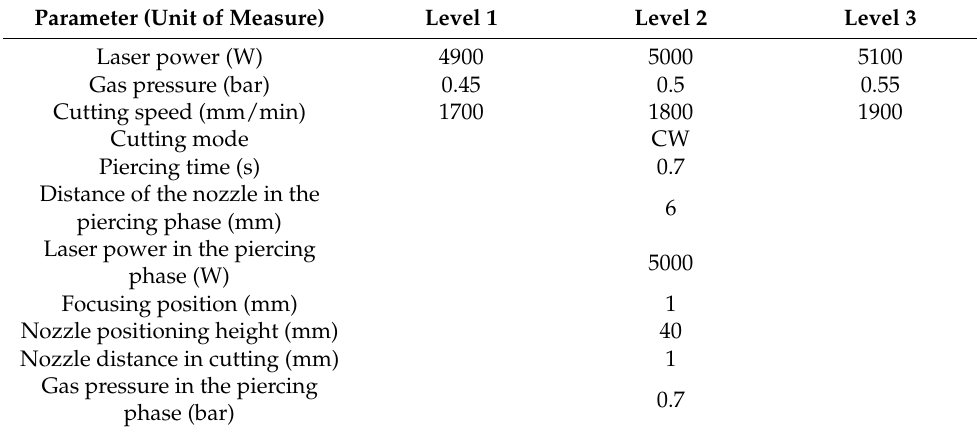
Table 1. Chemical composition Hardox 400 [7]. Alloying Element